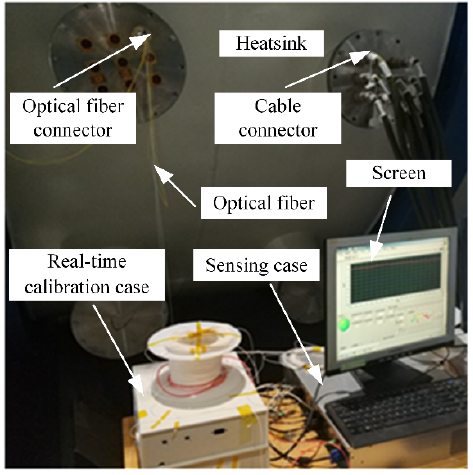
Figure 3. The equipment of the distributed optical fiber Raman temperature sensing system.